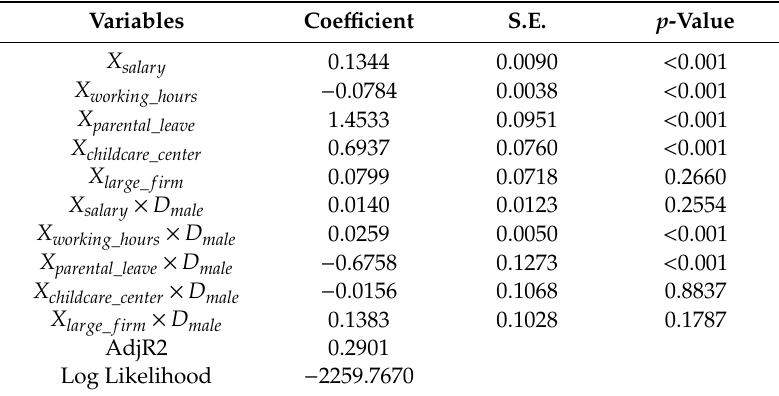
Table 7. Estimation results of the indirect utility function, by gender.